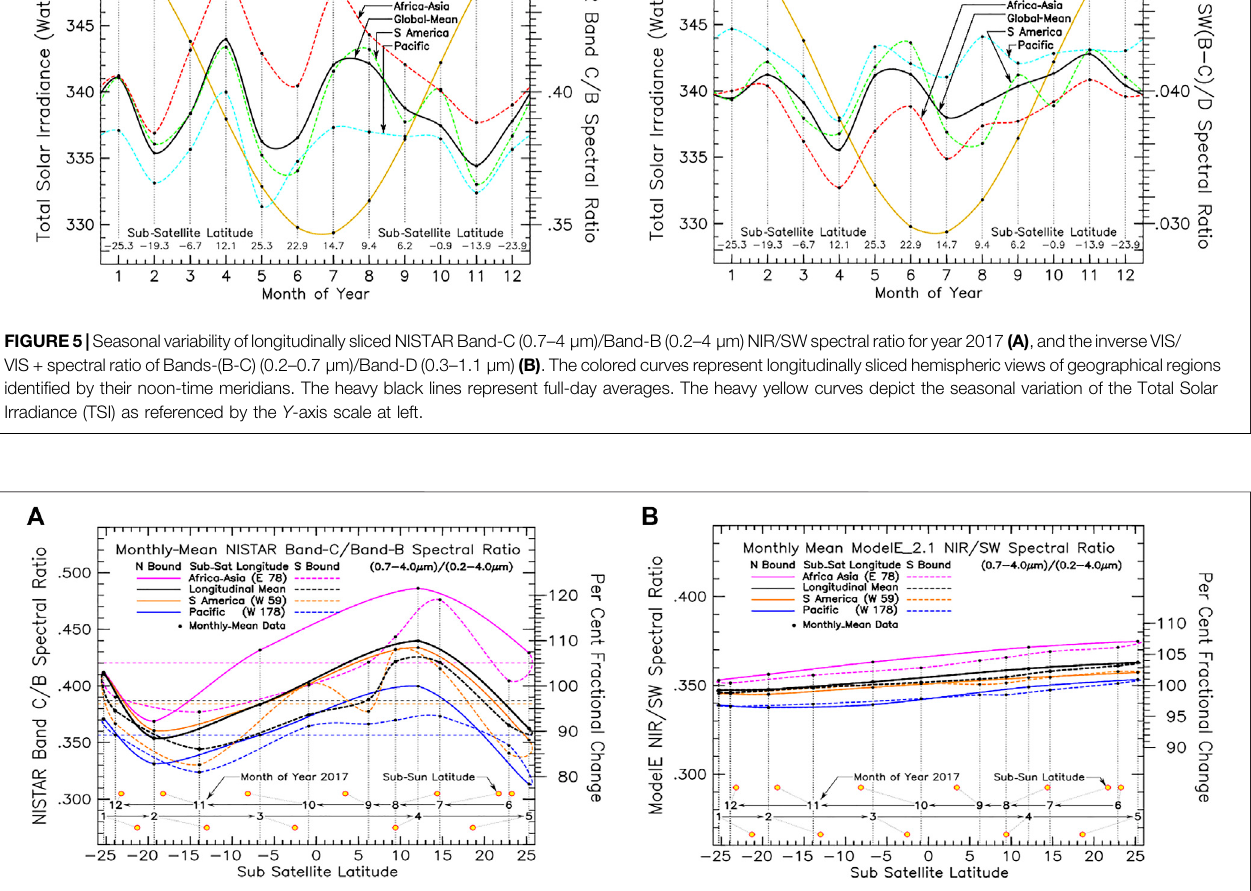
FIGURE 6 | Seasonal variability of longitudinally sliced NISTAR Band-C (0.7 – 4 μ m)/Band-B (0.2 – 4 μ m) NIR/SW spectral ratio for year 2017 (A) , expressed in pinwheelformat,andplottedasafunctionoftheDSCOVR sub-satellitelatitude. Notedat fi gurebottom arethemid-month positionsoftheDSCOVRspacecraftinterms of its sub-satellite location (numbers identify the month of year 2017), and the corresponding sub-solar latitude (declination) denoted by the yellow circles. At (B) are the corresponding NIR/SW spectral ratio results from the GISS ModelE2 re fl ected SW diagnostics output data sampled in accord with the DSCOVR Satellite Ephemeris viewing geometry and aggregated over the sunlit